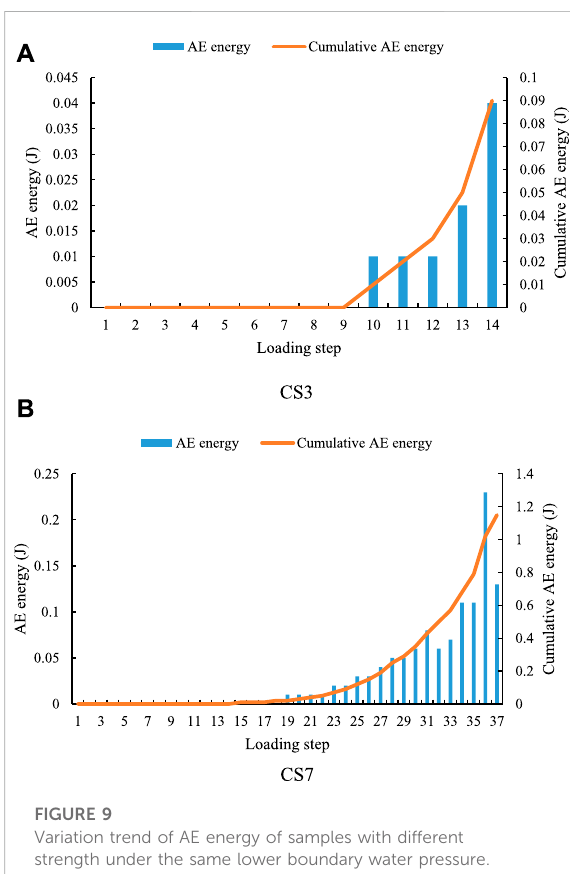
Variation trend of AE energy of samples with different strength under the same lower boundary water